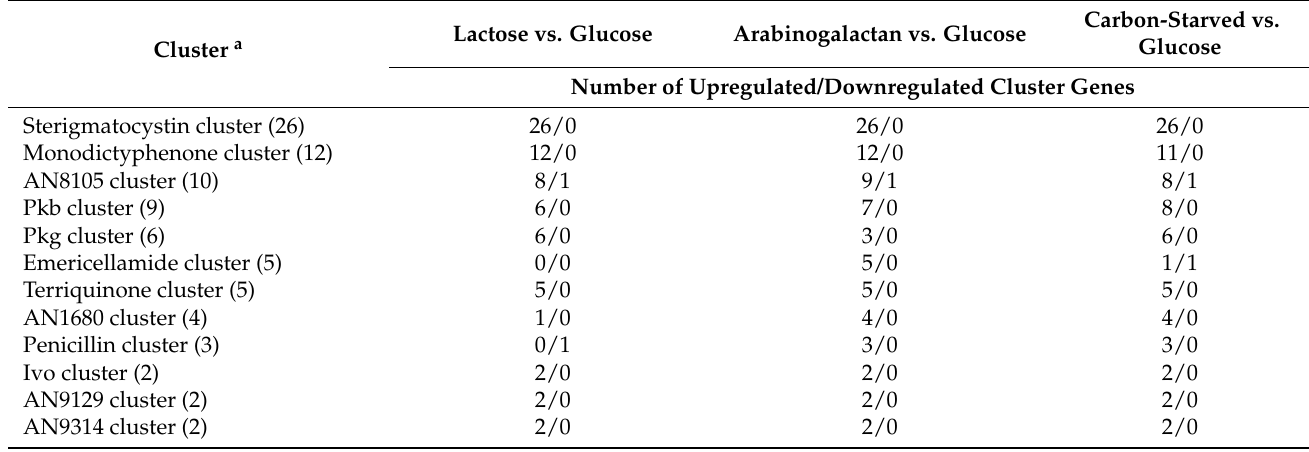
Table 5. List of selected secondary metabolism cluster genes upregulated by carbon stress in A. nidulans . Lactose vs. Glucose Arabinogalactan vs. Glucose